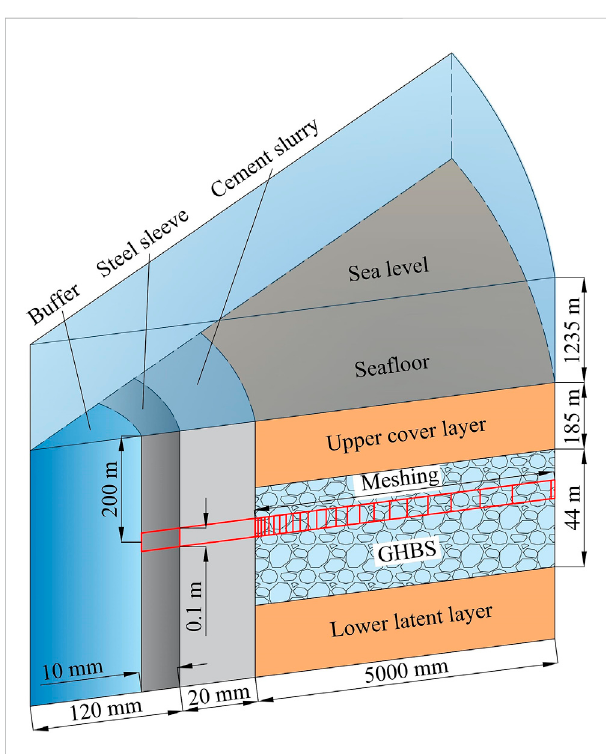
FIGURE 4 Schematic diagram of the wellbore-sediment numerical model for GHBS